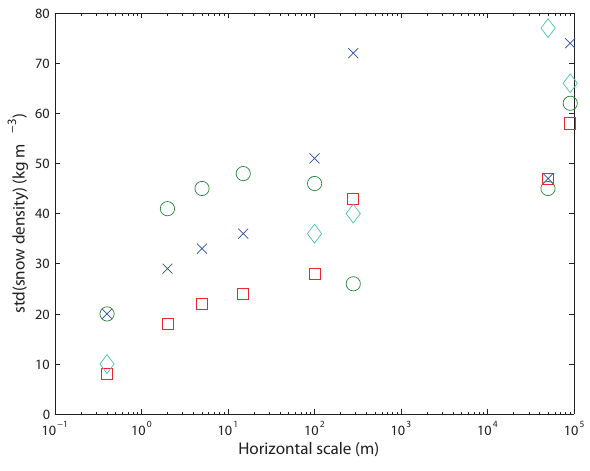
Fig. 14. Spatial standard deviation of snow density measured at var- ious sampling scales. The results for the horizontal scale of 280m are calculated on the basis of the data presented in Fig. 7 of Sturm and Benson (2004). The measurement depth is indicated by crosses for 0.02m, circles for 0.1m, squares for 0.2m, and diamonds for